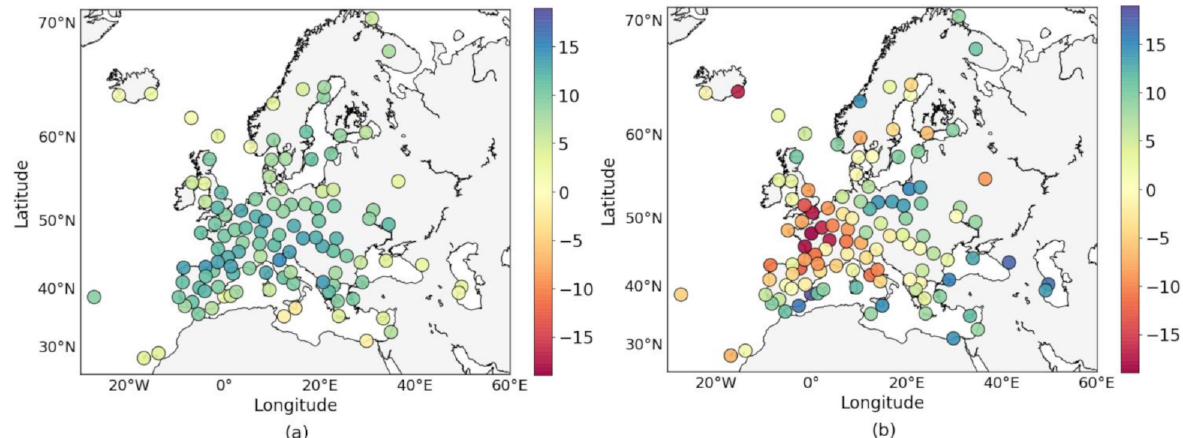
Figure 6. First ( a ) and second ( b ) spatial pattern of the weekly TWS residuals.